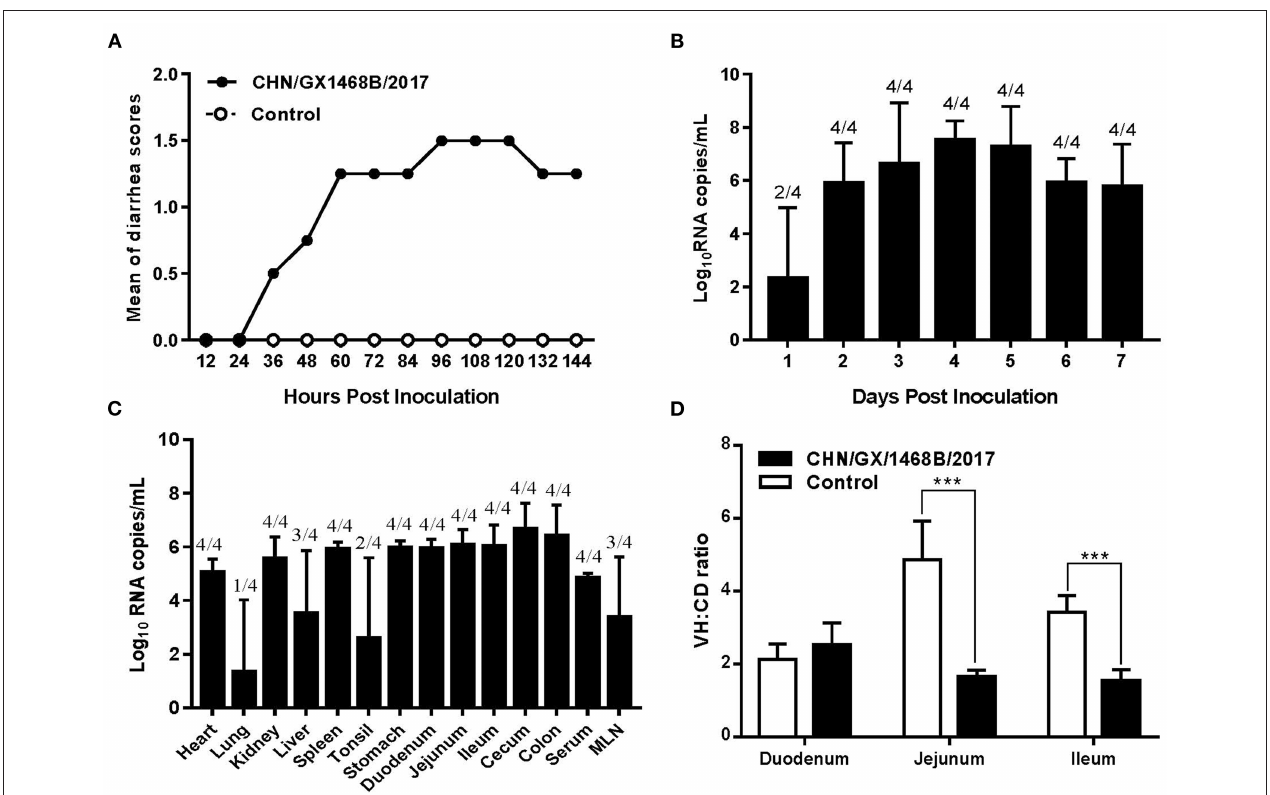
FIGURE 3 | Diarrhea scores, fecal viral shedding, virus distribution and the VH:CD ratios in piglets infected with the PDCoV CHN/GX/1468B/2017 strain. (A) Diarrhea scores of 7-day-old piglets challenged with the PDCoV CHN/GX/1468B/2017 strain. Clinical symptoms were monitored daily, and the severity of diarrhea for each piglet was scored using the following criteria: 0 = normal, 1 = fecal deformity, 2 = mild diarrhea, and 3 = watery diarrhea. (B) Fecal viral shedding in 7-day-old piglets challenged with the PDCoV CHN/GX/1468B/2017 strain. PDCoV RNA shedding in the feces was quantitated daily from the four challenged piglets. (C) Virus distribution in 7-day-old piglets challenged with the PDCoV CHN/GX/1468B/2017 strain. PDCoV RNA loads in tissues collected at 7 DPI were measured by using qRT-PCR. (D) The ratio of villous height to crypt depth (VH:CD) in small intestines from piglets inoculated with the PDCoV CHN/GX/1468B/2017 strain. Each point/bar represents the average values of four piglets, the numbers above the bar in graphs (B,C) represent the ratio of PDCoV positive piglets to the total in each group, and the asterisk indicates a statistically significant difference between the negative control and CHN/GX/1468B/2017 groups (*** p <